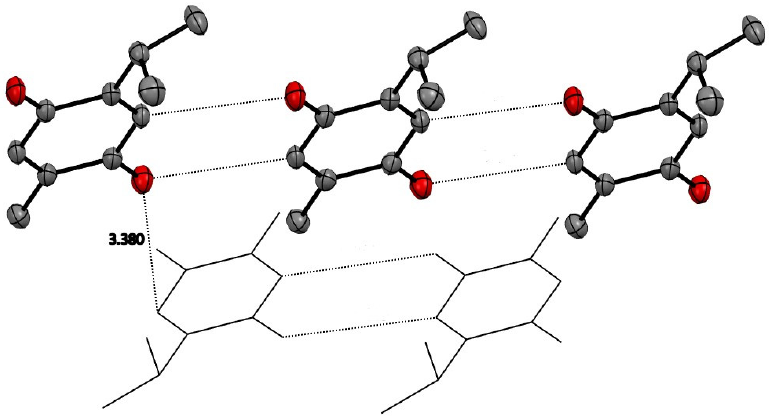
Figure 2. TQ molecules have planar quinone rings which have close contacts with other TQ molecules in the same plane of about 3.4 Å. Stacking between these planes is also about 3.4 Å. Hydrogen atoms removed for clarity.